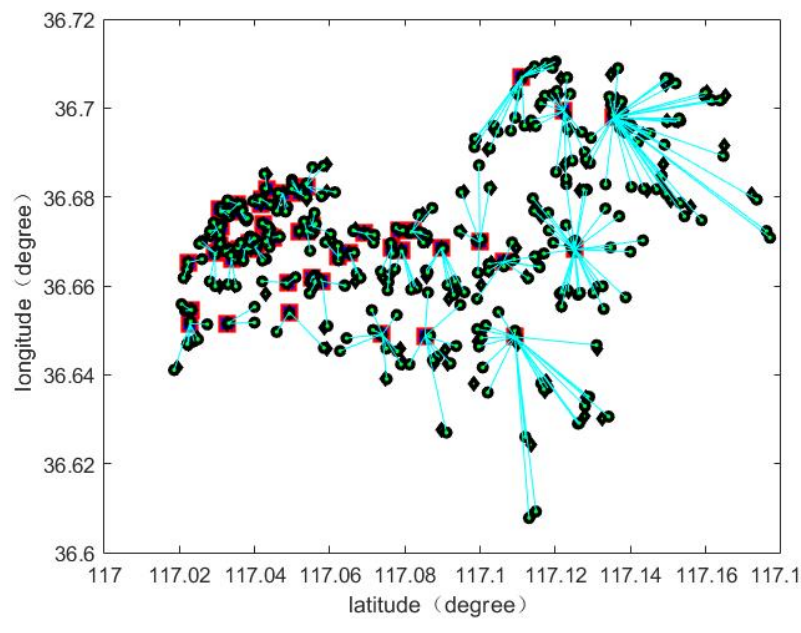
Figure 10. Site-selection scheme.